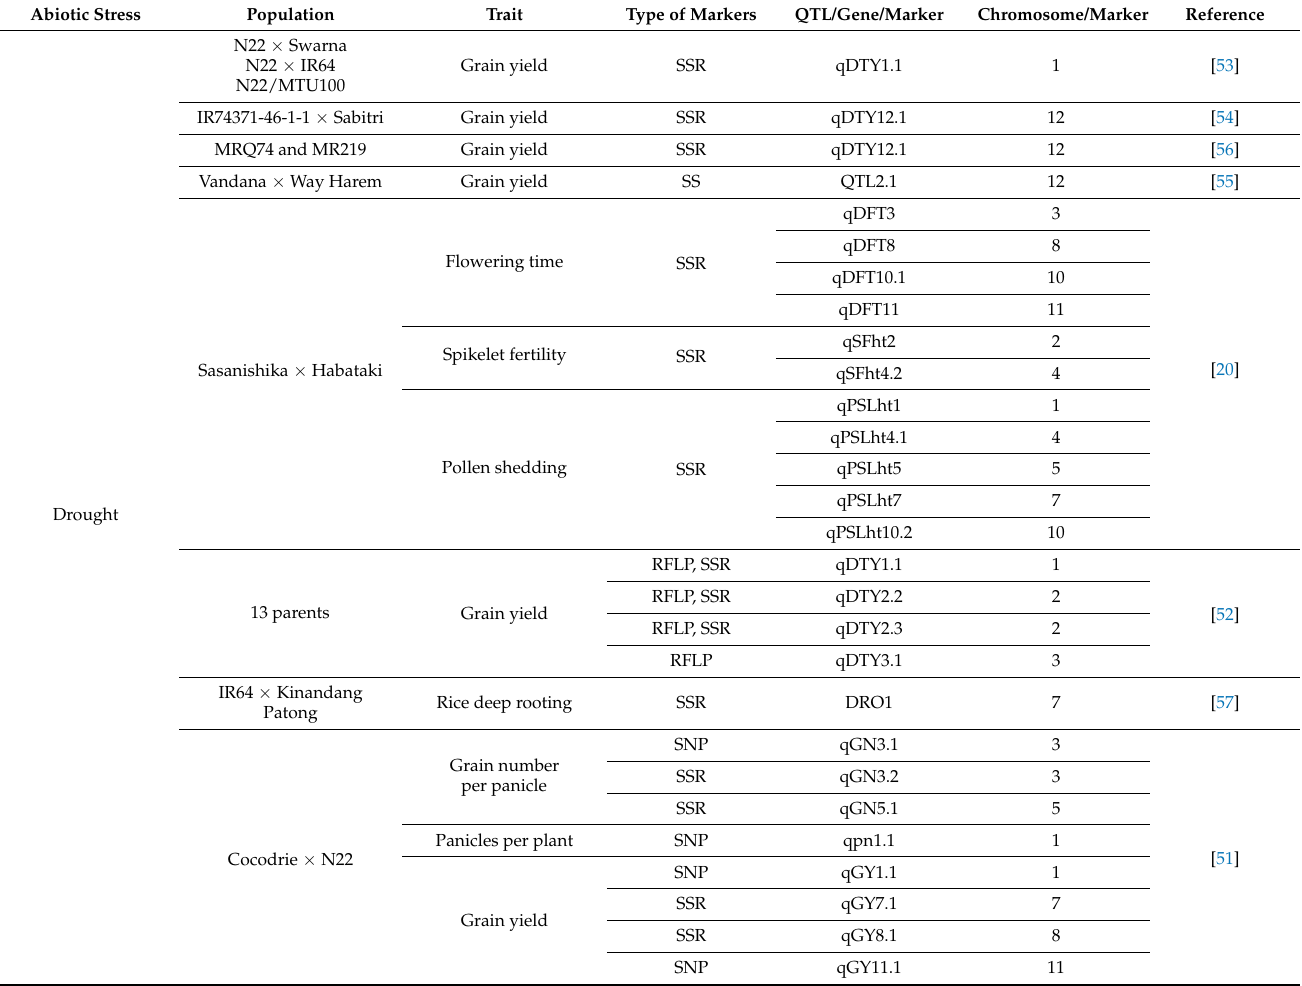
Table 1. List of QTL linked to abiotic stress tolerance in